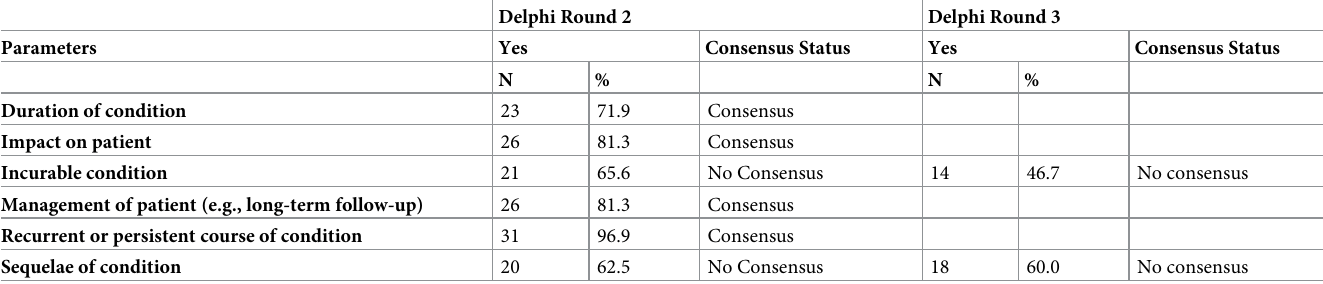
Table 2. Findings for parameters for defining a chronic